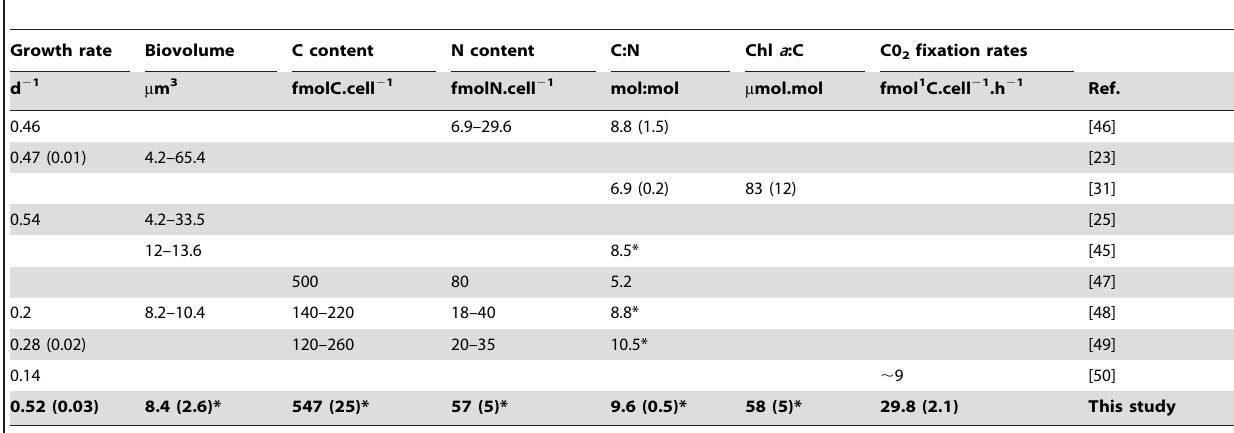
Table 2. Comparison of growth rate, biovolume, cellular contents, elemental ratio and CO 2 fixation rate of C. watsonii WH8501 cultivated under Fe-replete conditions (numbers in brackets represent standard